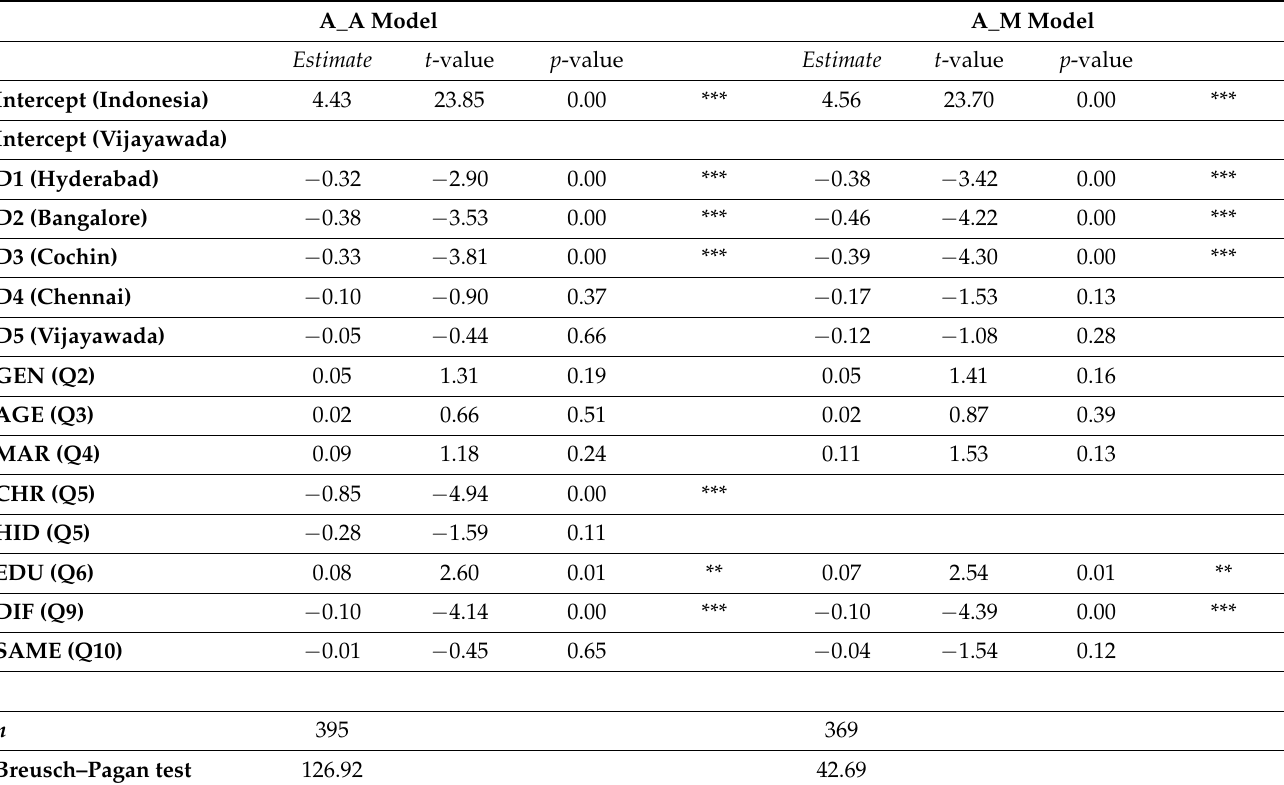
Table 6. Estimation results.